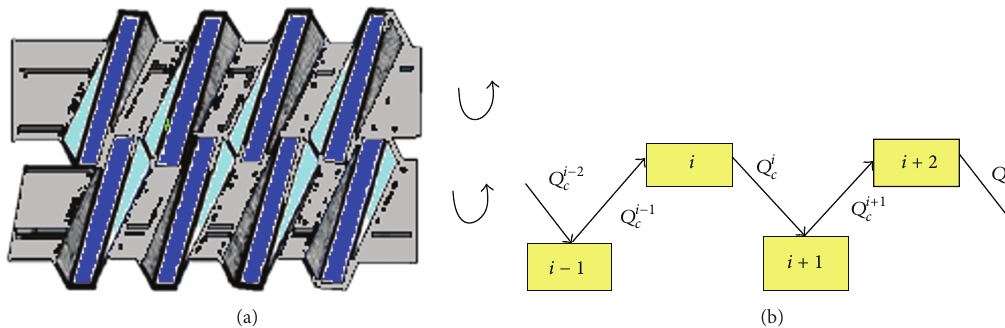
Figure 1: (a) Fully intermeshed corotating twin-screw extruder. (b) Interactions of the chambers (CSTRs) along the extruder.